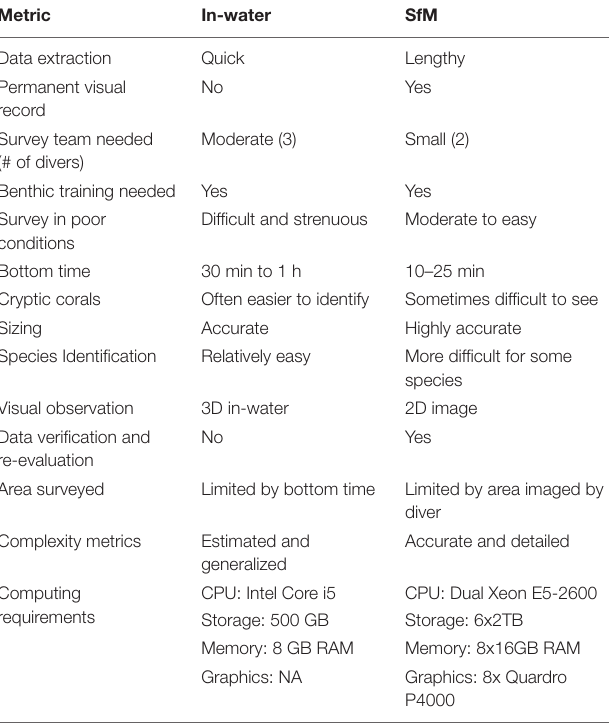
TABLE 1 | Comparison of in-water and SfM strengths and